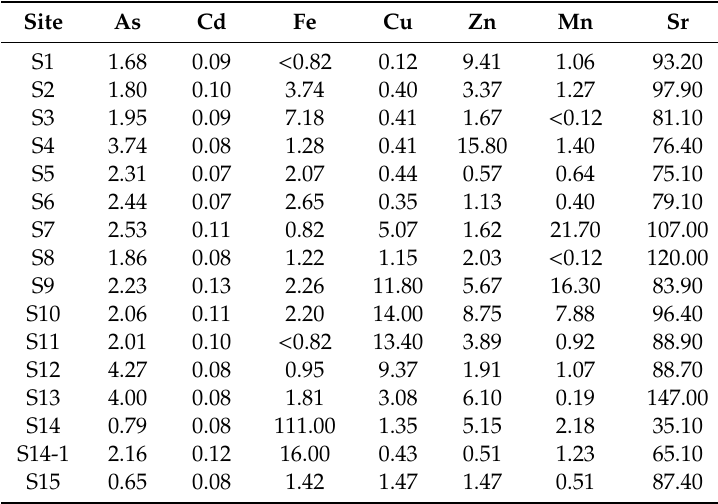
Table 5. The trace elements of the Lhasa River ( µ g /